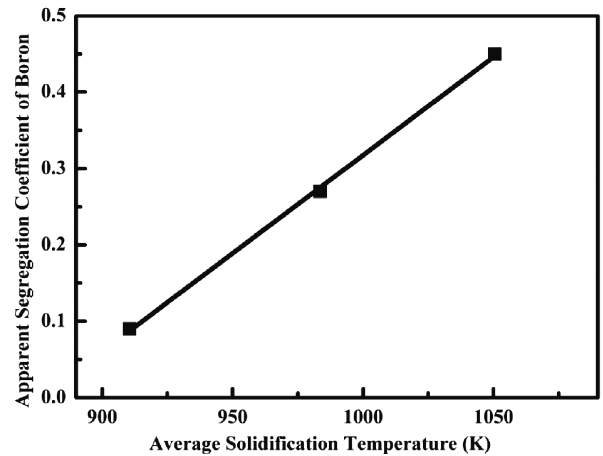
Fig. 2: Apparent segregation coefficient of boron in Al-Si